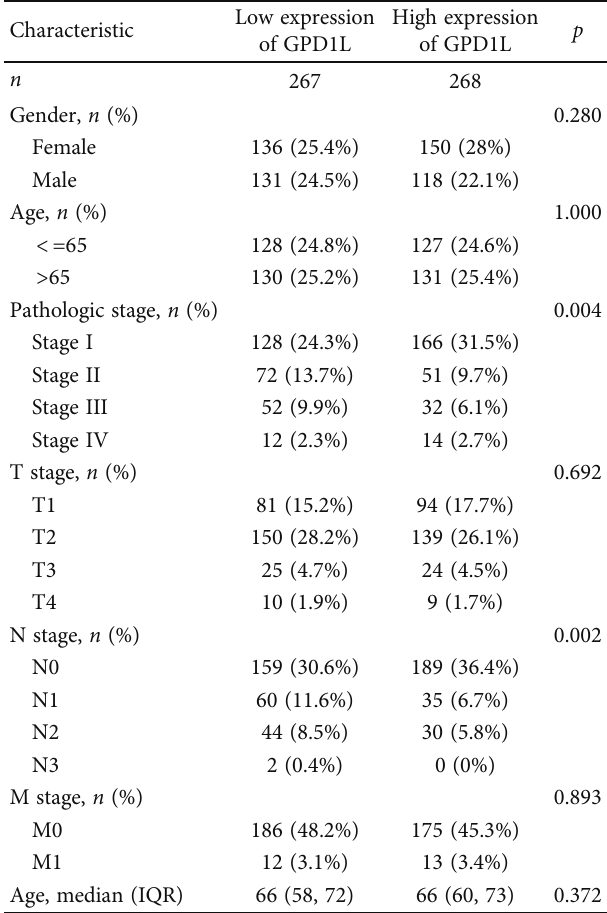
Table 1: The association between GPD1L expression and clinicopathological